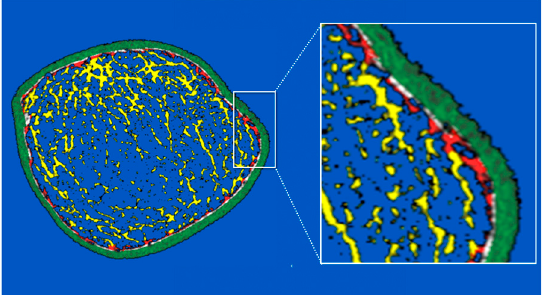
Figure 1. HR-pQCT image of the distal tibia of an 18-year-old male patient with a stress fracture. Compact appearing cortex (green); outer transitional zone (white); inner transitional zone (red); medullary area (yellow).